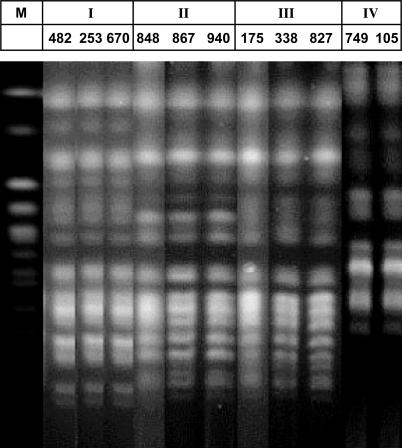
Karyotypes of Iranian
Leishmania Isolates as Determined by PFGE

Leishmania cells lysed in situ in agarose blocks were run in agarose gels, and chromosome-sized bands were resolved by CHEF electrophoresis. I, II, III, and IV represent the various karyotypes, and cardinal numbers represent the identification number of
Leishmania isolates (see
Table 2). M indicates
S. cerevisiae molecular-weight maker (BioRad).